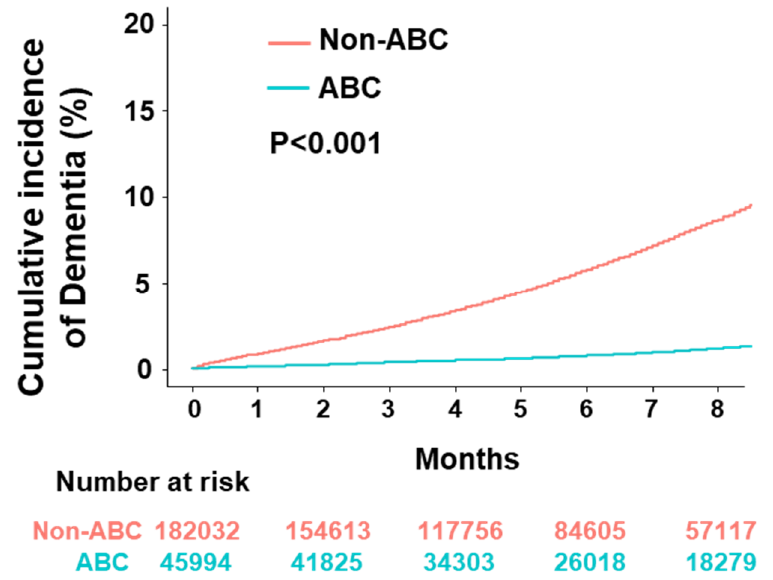
Figure 2. Cumulative incidences of dementia according to the use of integrated care (ABC).